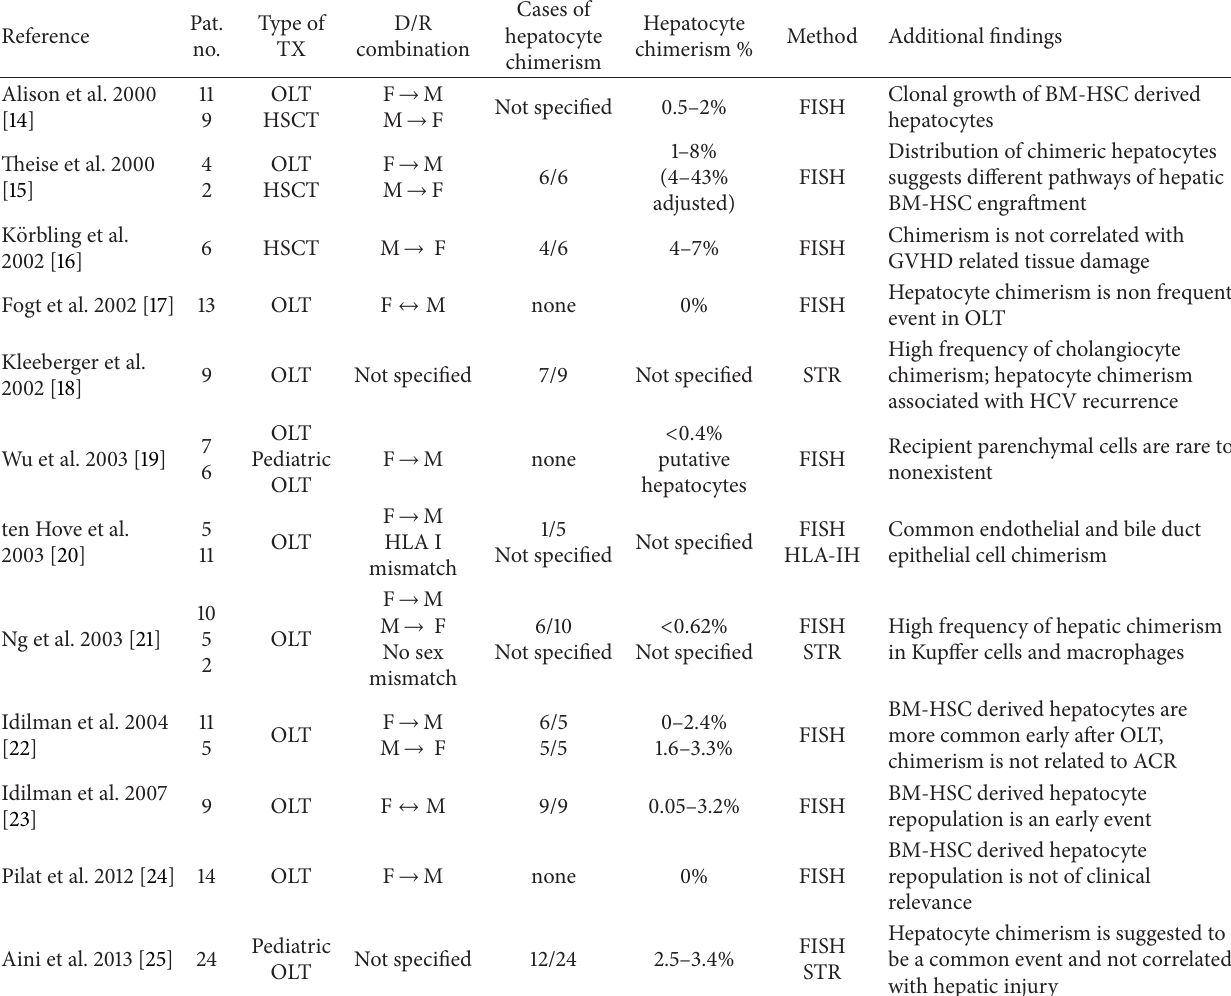
OLT: orthotopic liver transplantation, HSCT: hematopoietic stem cell transplantation, F: female, M: male, FISH: fluorescent in-situ hybridization, STR: short tandem repeat/microsatellite analysis, GVHD: graft-versus-host disease, HLA-IH: HLA specific immunohistochemistry, HCV: hepatitis C virus, and ACR: acute cellular